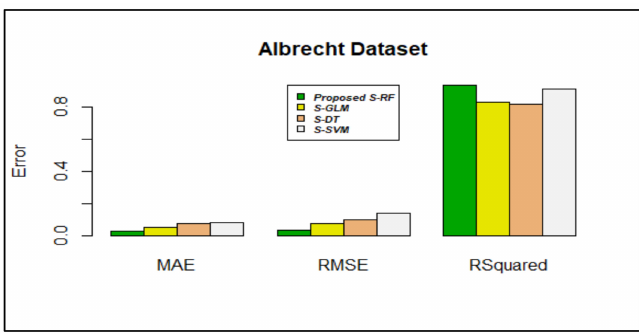
Figure 3. Error rate vs. stacking models in the Albrecht dataset.